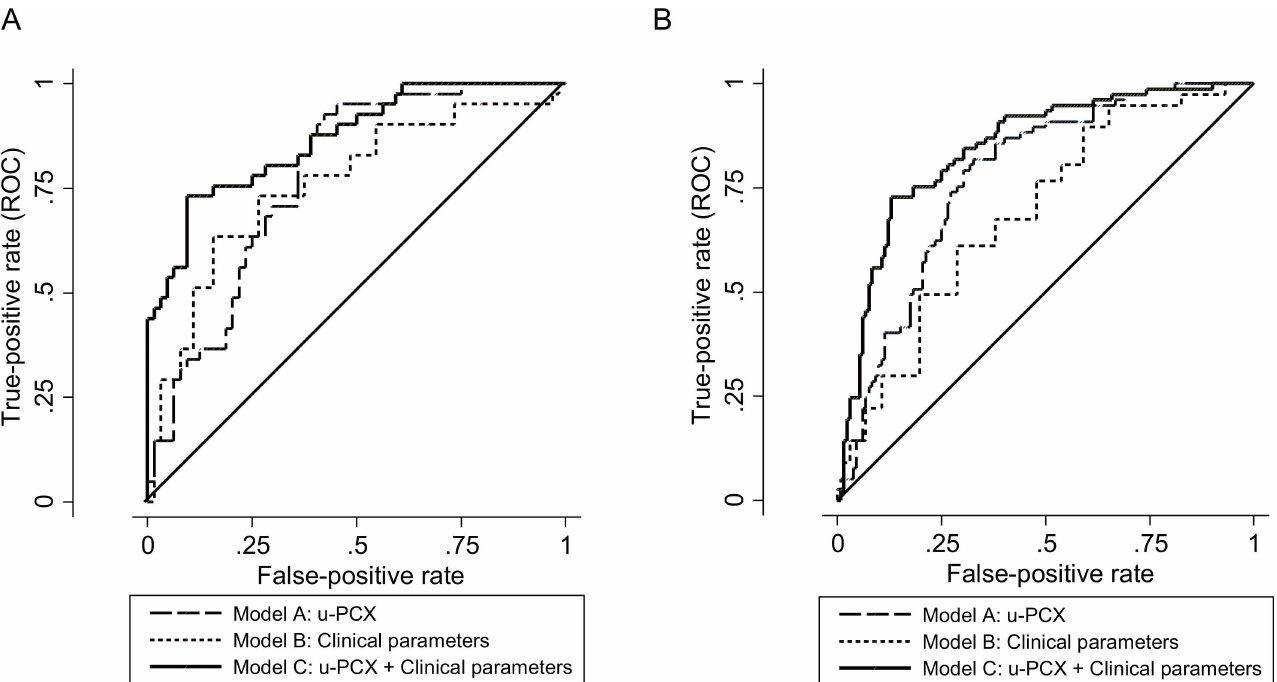
Fig 2. ROC curve. (A) Training cohort. AUC of each model is 0.777 [95% confidence interval (CI); 0.680–0.853] in Model A, 0.761 [95%CI; 0.652– 0.848] in Model B, and 0.868 [95%CI; 0.781–0.931]in Model C. P value is 0.019 (A v.s. C), and 0.003 (B v.s. C). (B) Validation cohort. AUC of each model is 0.776 [95% confidence interval (CI); 0.717–0.841] in Model A, 0.690 [95%CI; 0.610–0.757] in Model B, and 0.846 [95%CI; 0.784–0.896] in Model C. P value is 0.003 (A v.s. C), and less than 0.001 (B v.s. C).